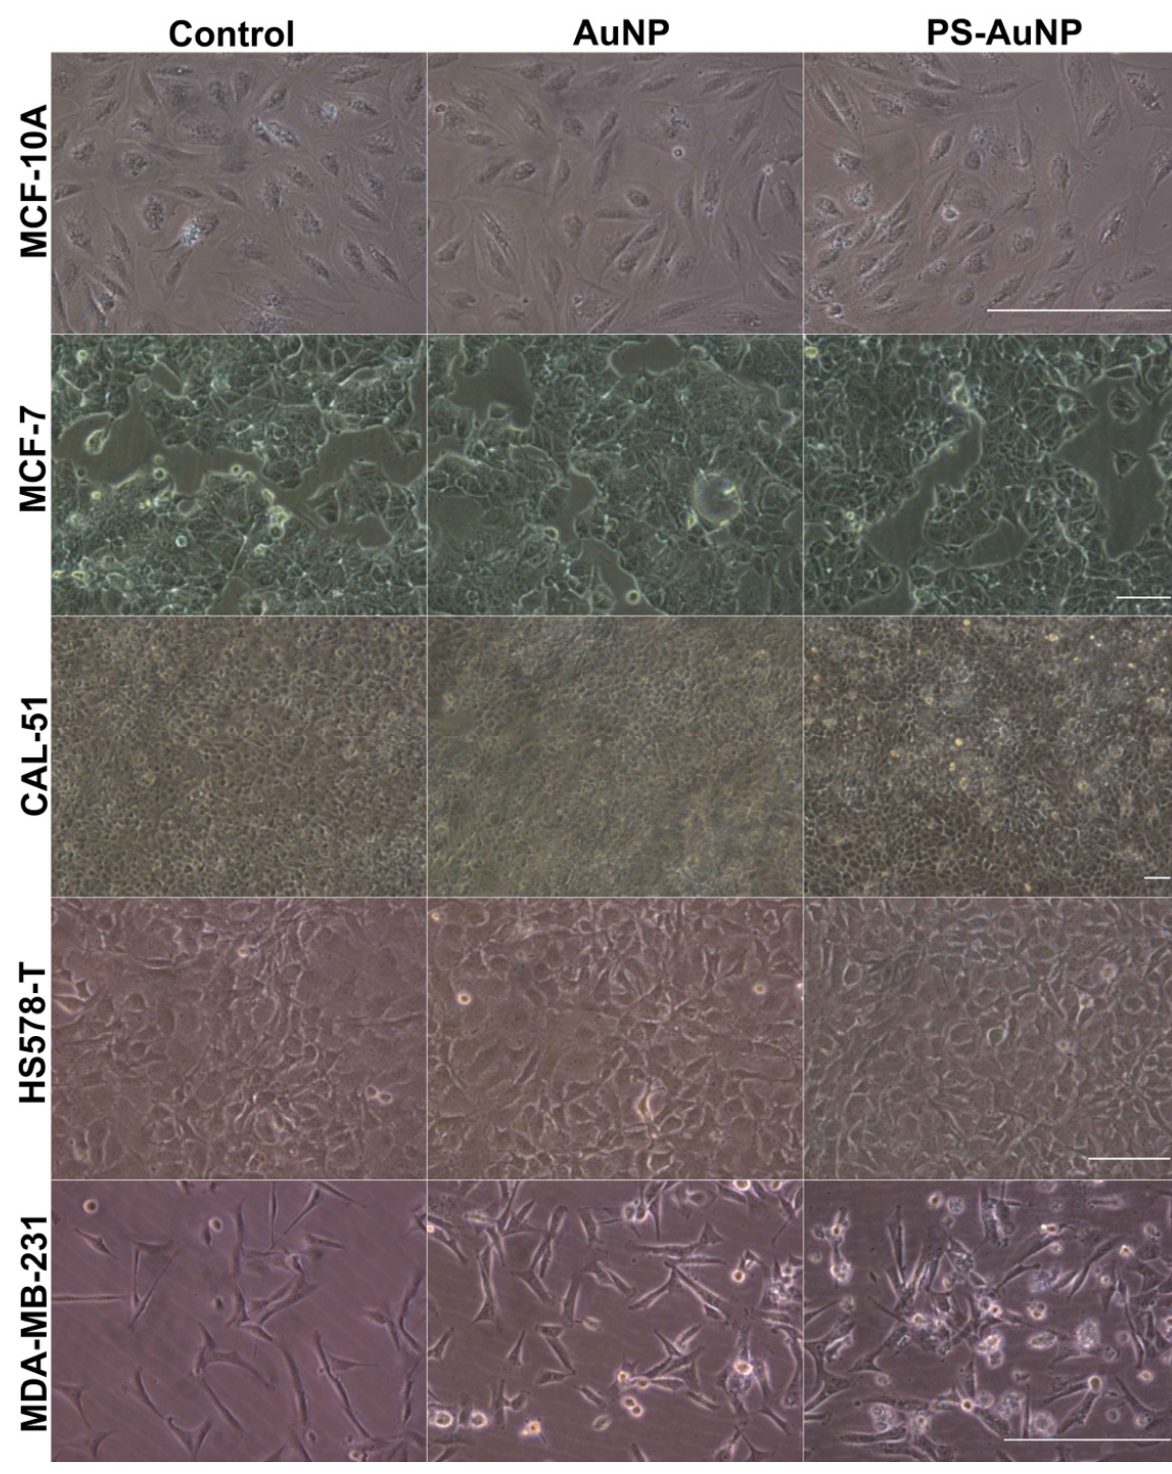
Figure 4. PS-AuNPs induces significant morphological changes in breast cancer (MDA-MB-231) cells compared to PBS-challenged cells (control) and the normal breast (MCF-10A) cell line. From top to bottom rows, light microscopy of the cell morphology of MCF-10A normal breast cell line and the breast cancer cell lines MCF-7, CAL-51, HS578-T, and MDA-MB-231. The left column shows cell lines challenged with PBS; the central column shows cell lines challenged with AuNP; and the right column shows cell lines challenged with PS-AuNP. Scalebar equivalent to 50 µm.